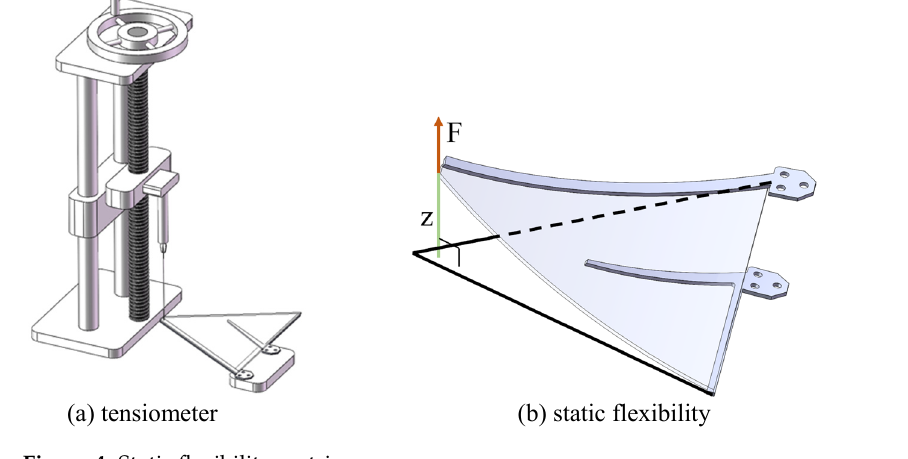
Figure 4. Static flexibility metric. Table 3. Relative flexibility.